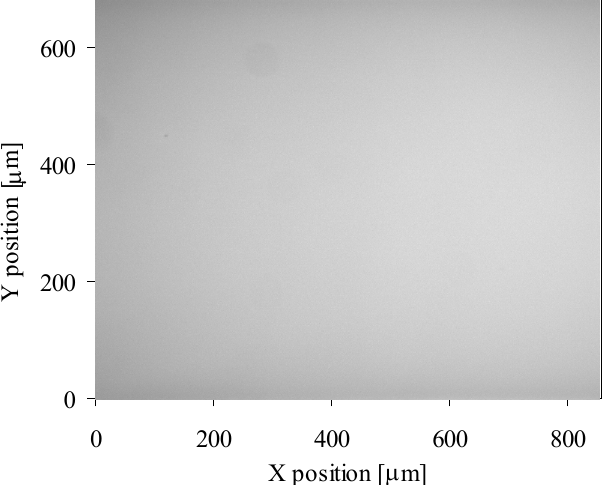
Fig. 4 Fluorescence image in microchip for calibration